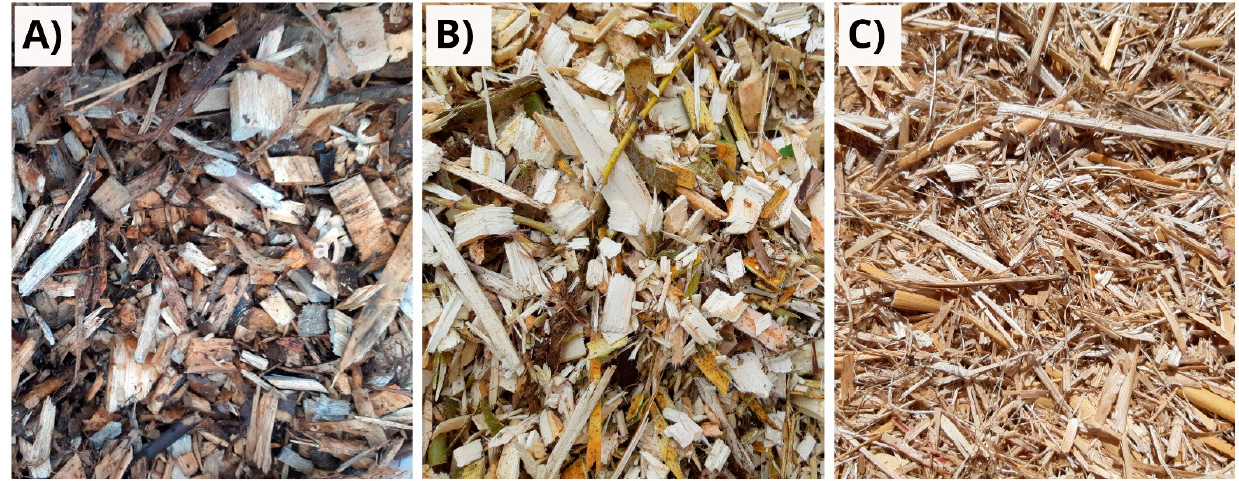
Figure 1. Chopped materials used as soil amendments in this study (from left): ( A ) forest mix; ( B ) willow; and ( C ) miscanthus. Table 2. Amendment properties (dry weight